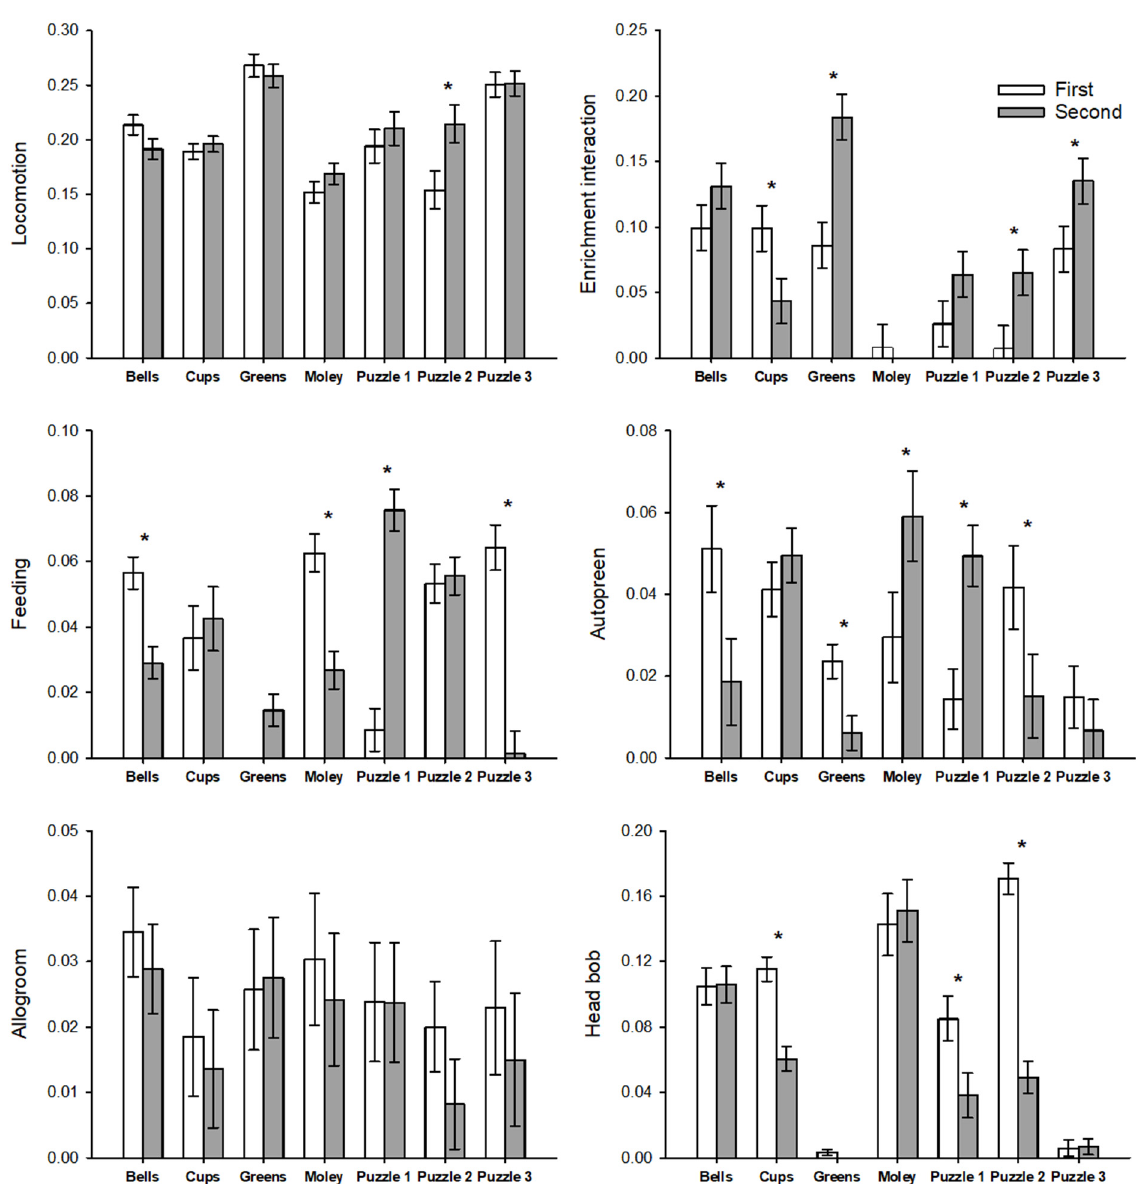
Figure 5. Differences in behaviors based on the interaction effect of a given enrichment item and the presentation round of that item in the post-enrichment addition period. Behaviors are listed on the y-axis, with units of proportion of scans [log(x + 1) transformed]. Asterisks indicate significant differences between the first and second presentation of that item.